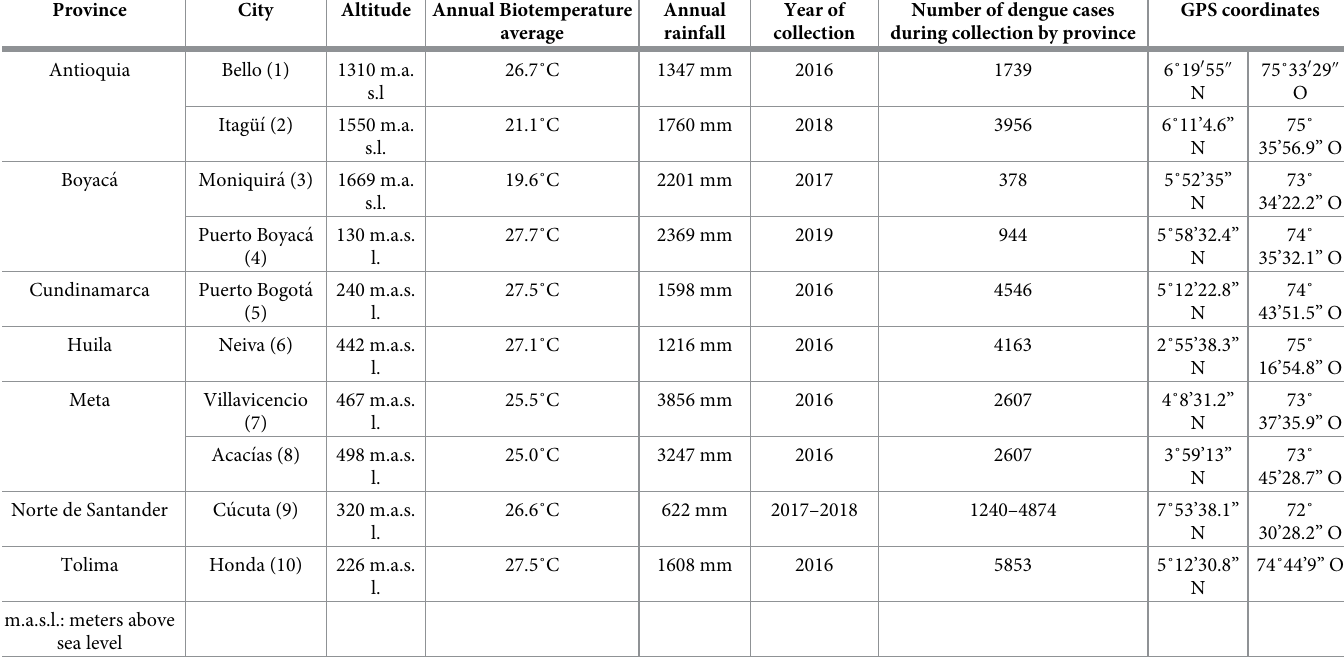
Table 2. Eco-epidemiological information for Aedes aegypti populations collected from seven provinces. Province City Altitude Annual Biotemperature